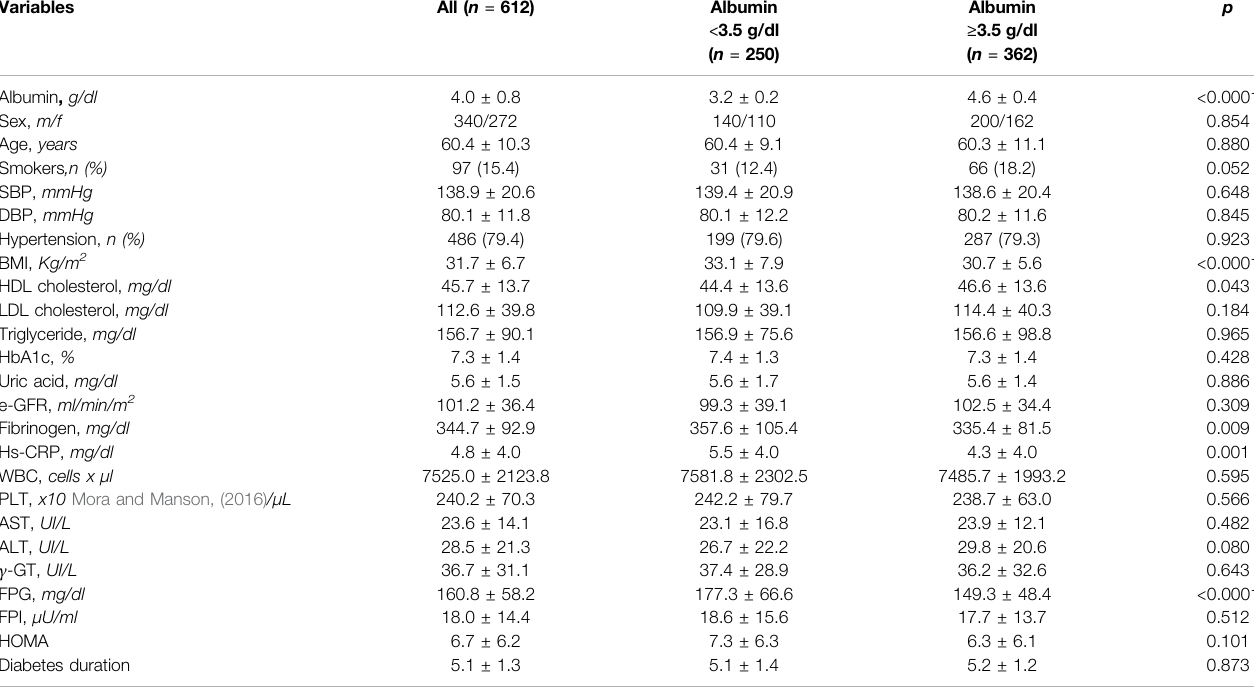
TABLE 1 | Baseline characteristics of the study population according to serum albumin levels. Variables